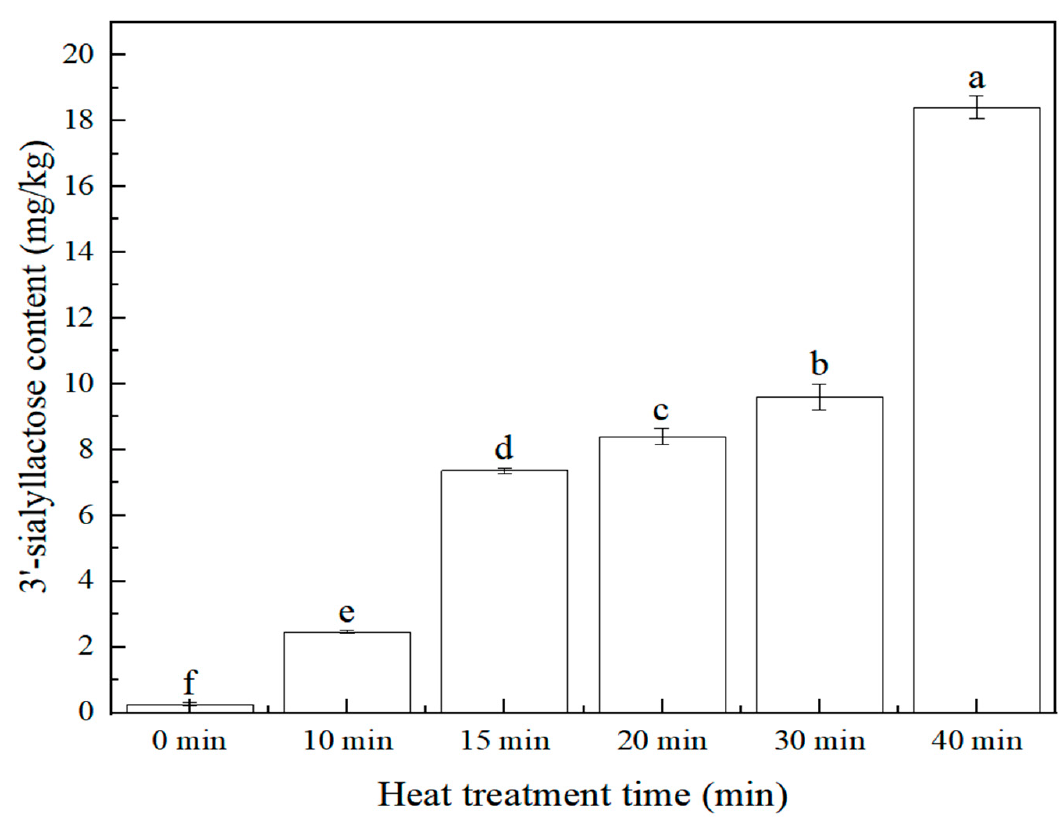
Figure 6. Relationship between 3’-sialyllactose content and heat treatment time ( n = 2, p < 0.05).